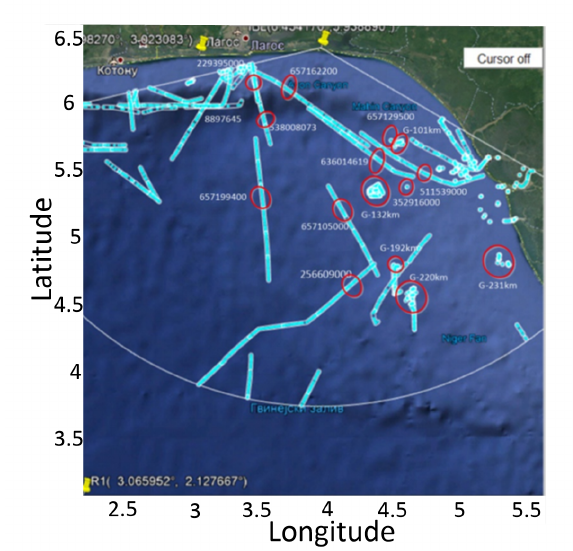
Figure 17. The complete AIS data in a time interval of approximately 5 h and randomly selected 10 vessels with their MMSI identifiers and 5 stationary located groups of vessels with G identifiers. First, a contour is formed around the AIS data, where the width of the contour is equal to the size of the initial resolution cell of 1.5 km. Then the criterion was made so that the detections and AIS data are monitored for one hour, hour by hour. According to this criterion, if the detection is within the contour we will consider that the real detection and not a false alarm. Figure 18 illustrate the forming of the criterion contour.